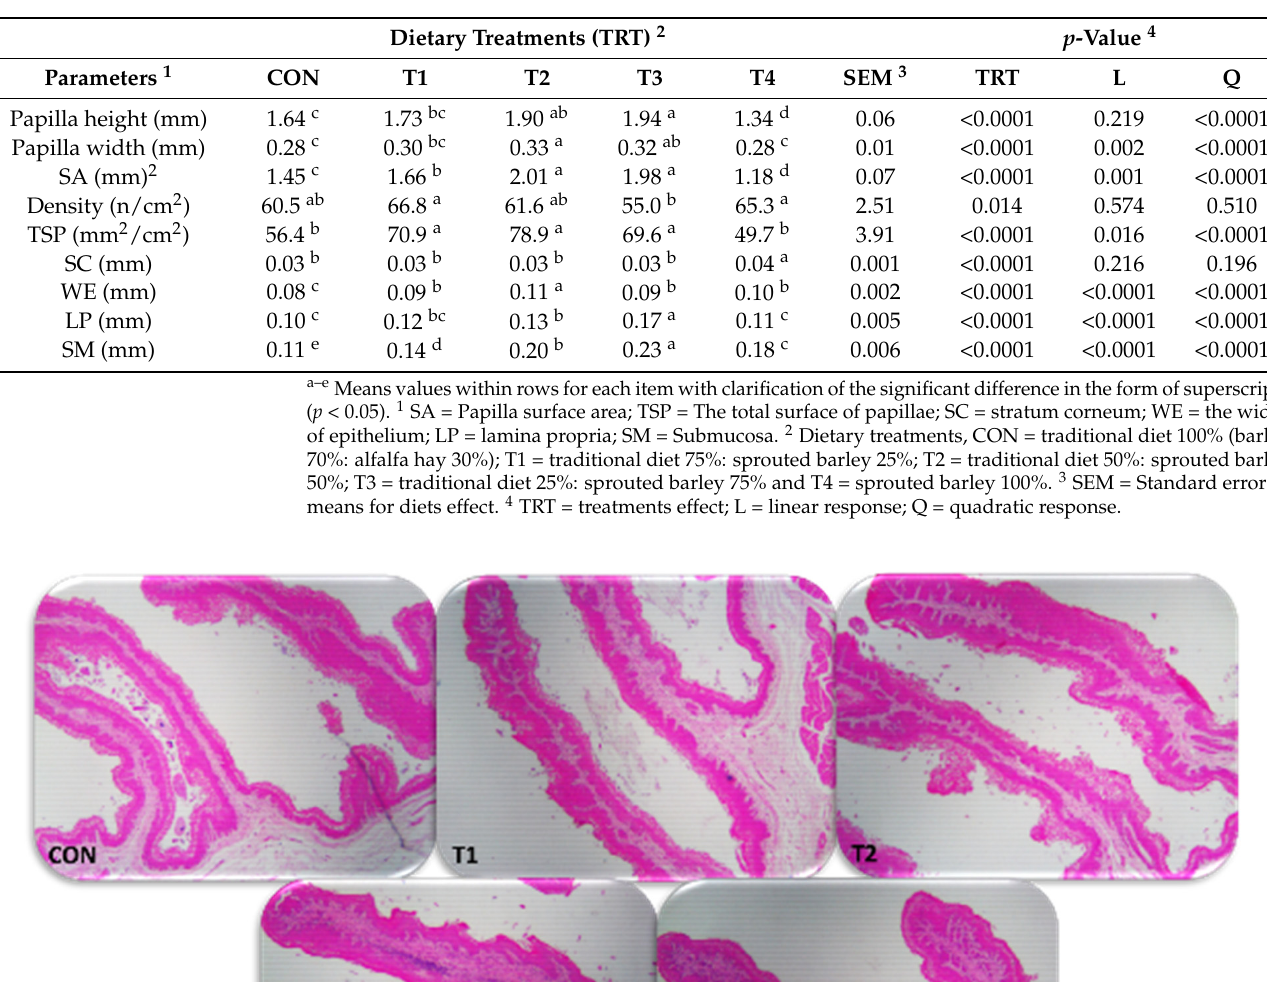
Table 7. Pearson Correlation between volatile fatty acid and pH values or rumen histometeric.